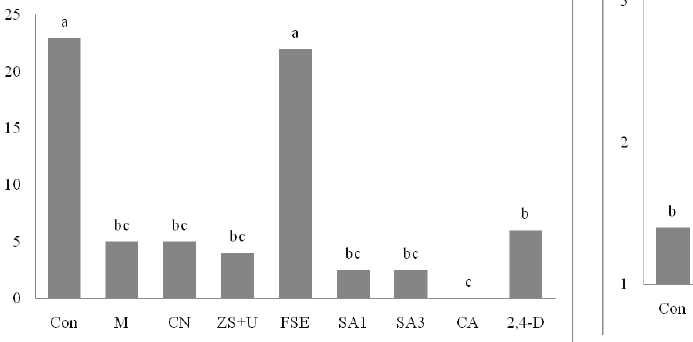
Figure 5: Effect of foliar-applied methanol (M), calcium nitrate (CN), zinc sulfate + urea (ZS+U), fermented sugarcane extract (FSE), salicylic acid 1 and 3 mM (SA1 and SA3), citric acid (CA), 2,4-dichlo- rophenoxyacetic acid (2,4-D) and water (Con) on fruit flavor of ‘Thompson Navel’ orange. 1= sour, 2= subacid and 3= sweet.